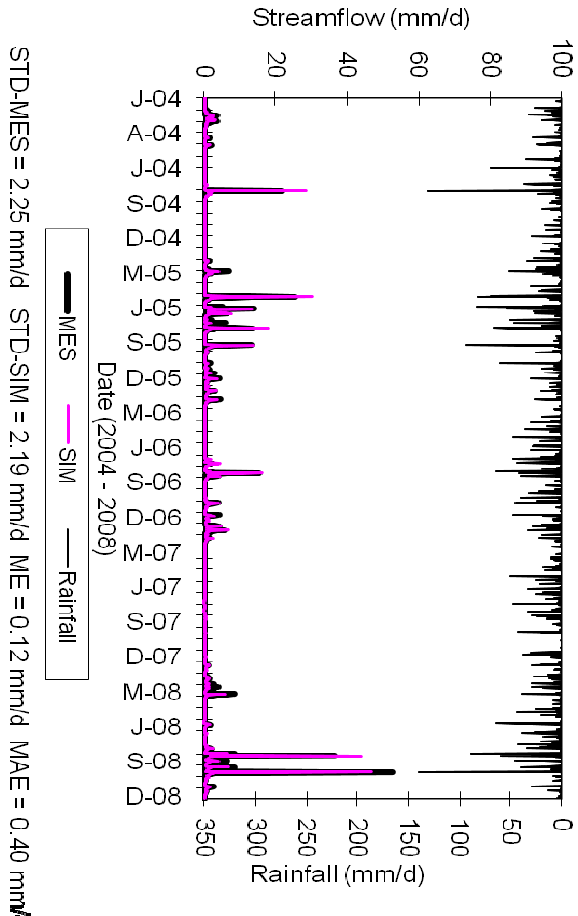
Fig.7a. Daily streamflow in 2004-08. Fig. 7a. Daily streamflow in 2004–2008. MES is measurement; MES is measurement; SIM is simulation; STD is standard deviation; ME is mean error between SIM is simulation; STD is standard deviation; ME is mean error simulation and observation; MAE is mean absolute error between simulation and observation. between simulation and observation; MAE is mean absolute error between simulation and